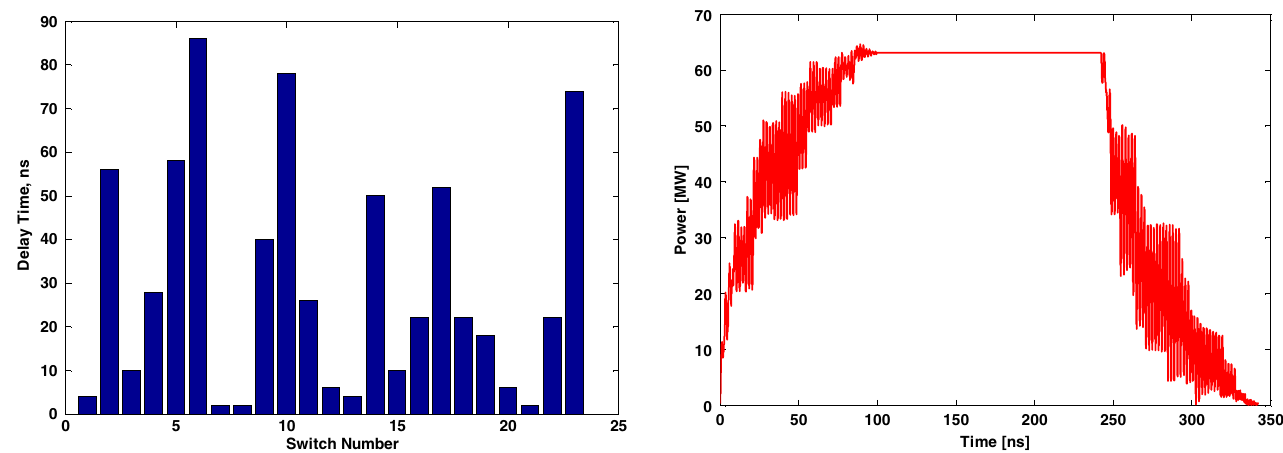
FIG. 15. Switching delays for the optimal pulse generation. FIG. 16. Input power of the CLIC optimized